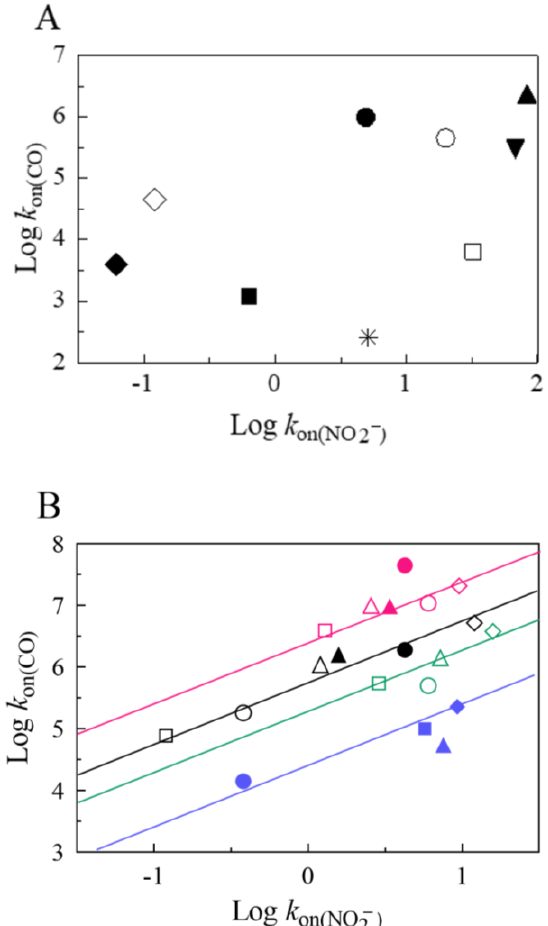
Figure 5. Correlation between the second-order rate constant of nitrite reductase activity (Log kon(NO 2 − )) and the CO-binding bimolecular rate constant (Log k on(CO) ). ( A ) Six-coordinated heme proteins: At -Hb(II) class 1 (open circle) 1, At -Hb(II) class 2 (filled circle), S -Hb(II) (filled downward triangle), rice nonsymbiotic Hb(II) class 1 (filled upward triangle), Mm -Nb(II) (asterisk), Hs -Ngb(II) CysCD4-CysD5 (open diamond), Hs -Ngb(II) CysCD4/CysD5 (filled diamond), Hs -Cygb(II) CysB2- CysE9 (open square), and Hs -Cygb(II) CysB2/CysE9 (filled square). ( B ) Five-coordinated heme proteins. Class I (red symbols and straight line): fast-reacting form of Cj -trHbP(II) (filled circle), Hs -heme(II)-albumin (open square), Efc -Cytc(II)-CL (open triangle), Efc -MP-11(II) (filled triangle), the fast-reacting form of Ma -Pgb(II) (open diamond), and Hs -Hb(II)) in the R-state (open circle). Class II (black symbols and straight line): Hs -Hb(II) in the T-state (open square), slow-reacting form of Ma -Pgb(II) (open triangle), carboxymethylated Efc -Cytc(II) (filled triangle), Hs -Hp2-2:Hb(II) (open diamond), slow-reacting form of Cj -trHbP(II) (filled circle), and fast-reacting form of Mt -trHbO(II) (open circle). Class III (green symbols and straight line): Efc -Mb(II) (open square), Pc-Mb(II) (open circle), Hs -Hp1-1:Hb(II) (open triangle), and Mt -trHbN(II) (open diamond). Class IV (purple symbols and straight line): Mt -trHbO(II) (filled circle), Mt -Nb(II) filled triangle), At -Nb(II) (filled diamond), and Hs -Nb(II) (filled